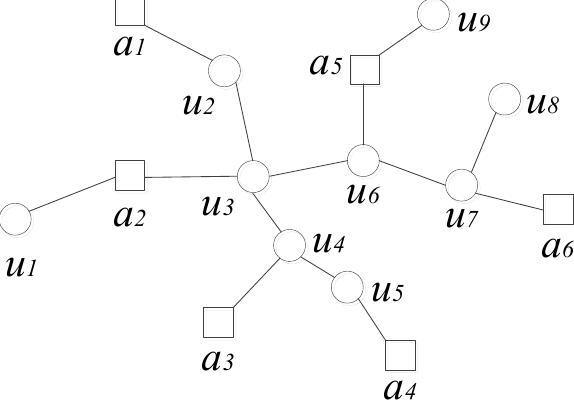
Figure 5. Schematic diagram of similar path search.